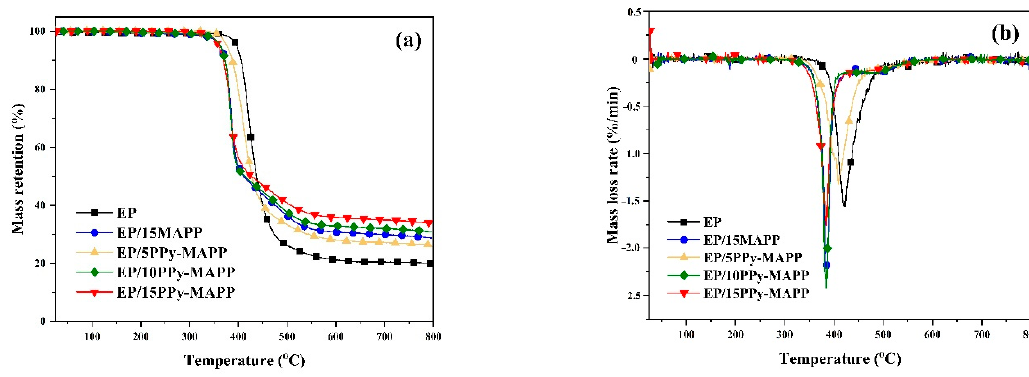
Figure 5. TG ( a ) and DTG ( b ) curves of EP and flame-retarded EPs. Table 2. Typical thermal data of flame-retarded epoxy resins. Samples